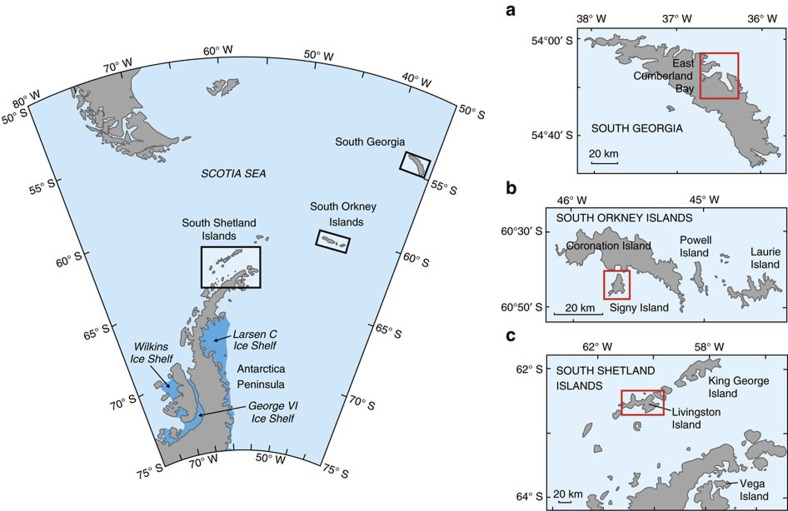
The Antarctic Peninsula and the islands visited during this study.Red boxes show the specific field study areas: (a) East Cumberland Bay, South Georgia; (b) Signy Island and (c) Hurd Peninsula, Livingston Island.